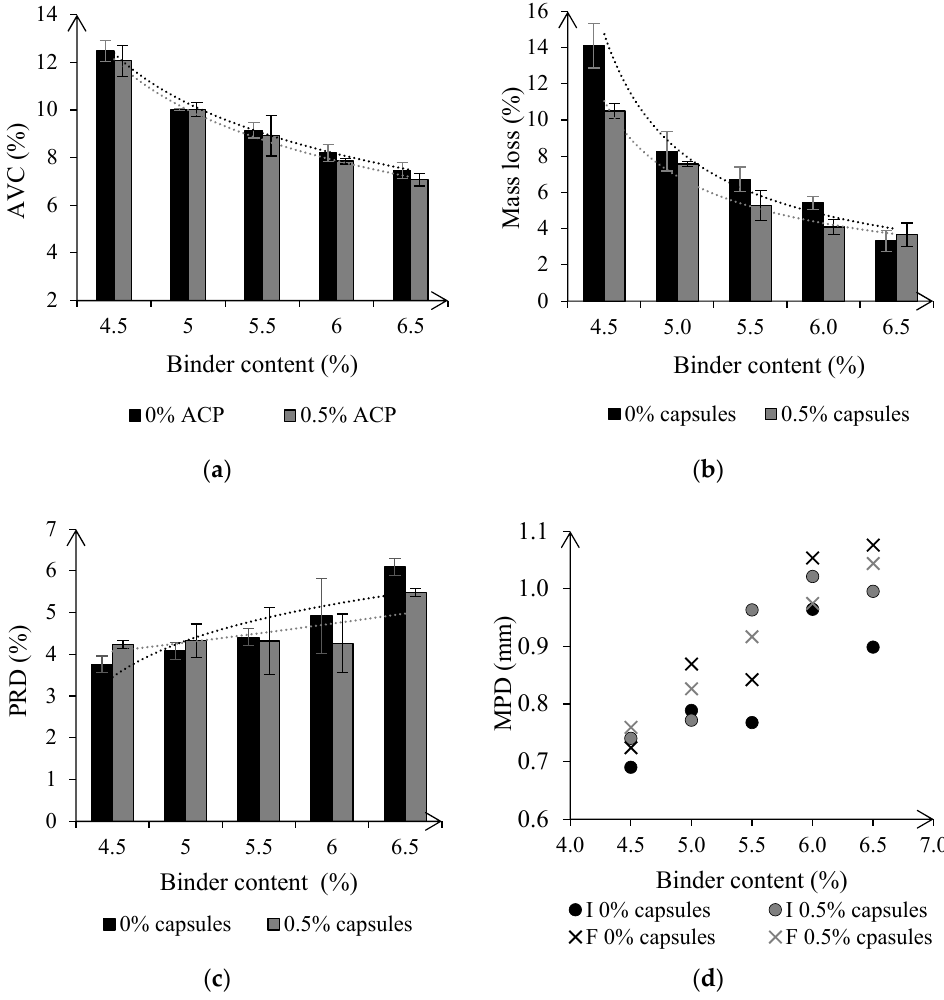
Figure 9. Testing of NTEC asphalt mixtures with different binder contents with 0% and 0.5% of cellular capsules: ( a ) AVC values of asphalt mixes, ( b ) ravelling resistance, ( c ) rutting resistance and ( d ) initial and final asphalt’s macrotexture during the Hamburg wheel tracking test.